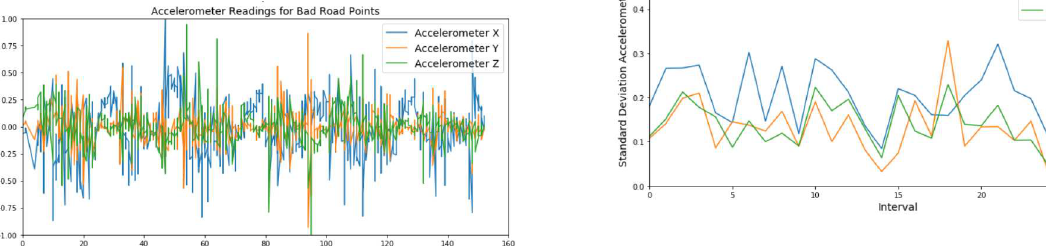
Figure 6. Accelerometer Standard Deviations of Bad Road